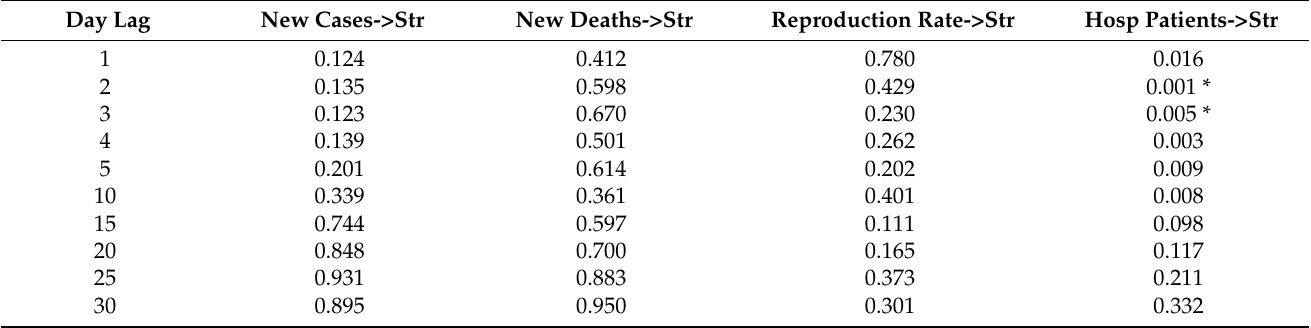
Table A9. Intensity variables, Granger-cause Stringency_index (Str), and p -values in day lags in Poland.